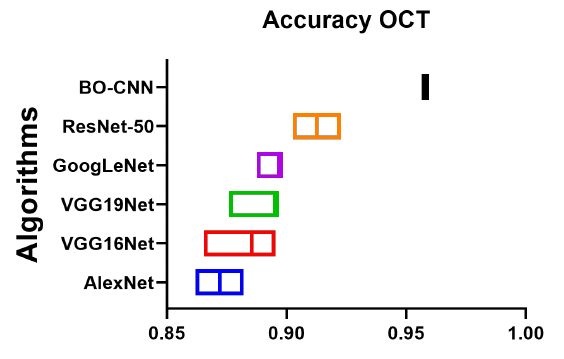
Figure 13. Box plot of the proposed BO-CNN model vs. pre-trained-CNN models for the IDRiD dataset based on accuracy.